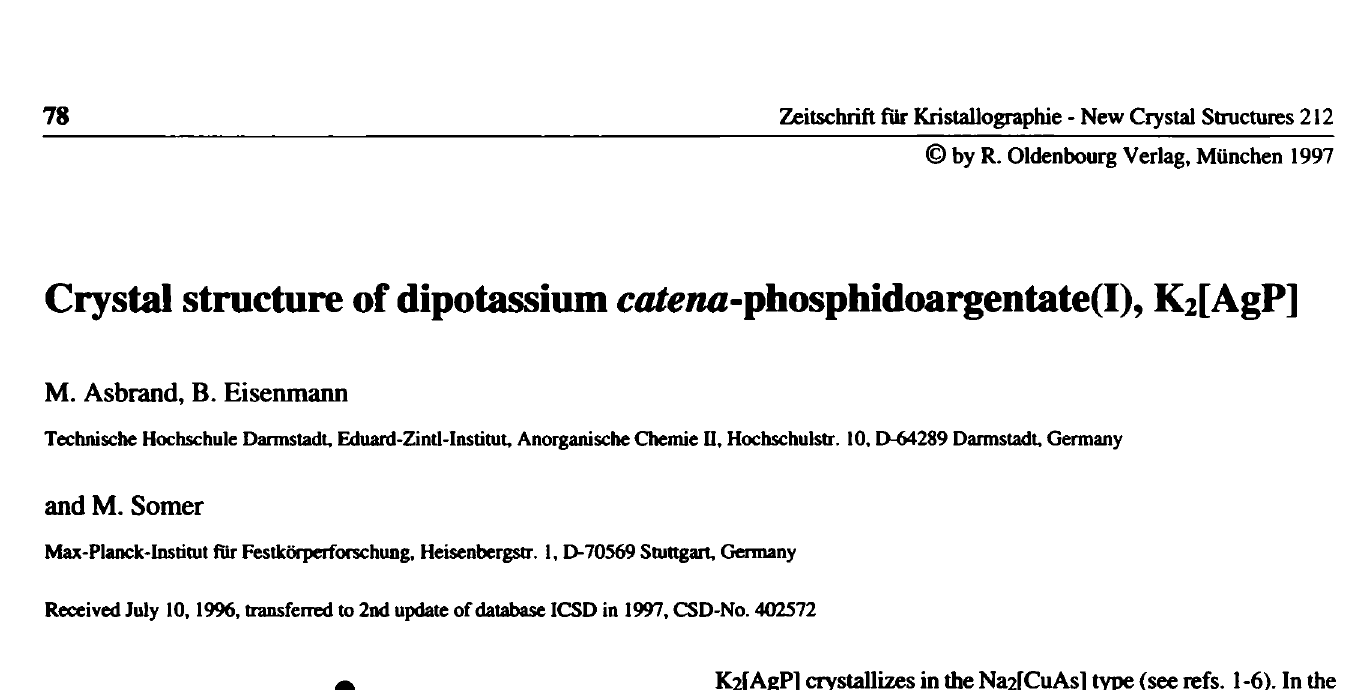
Table 1. Parameters used for the X-ray data collection Crystal: